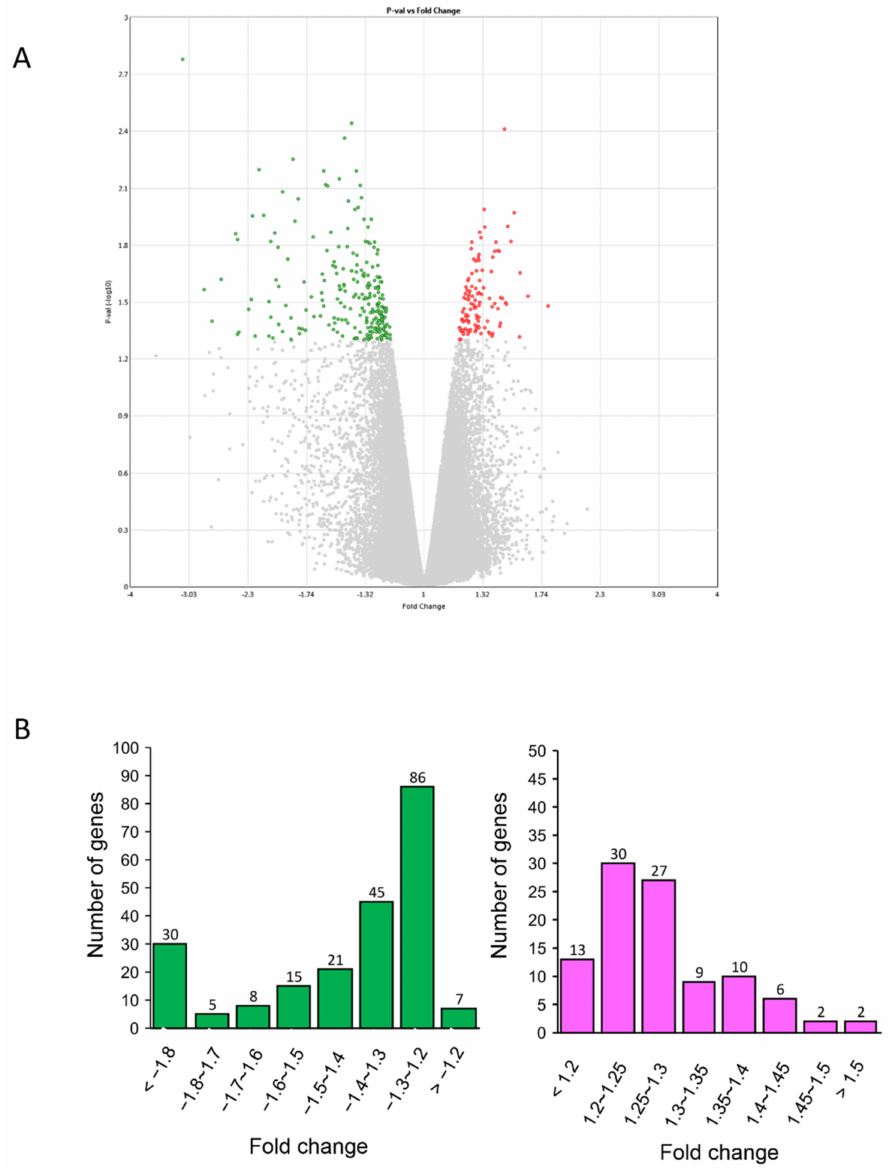
Figure 1. Characterization of gene expression profiles in human amniotic epithelial cells (hAECs) with or without cyanidin-3- O -glucoside (Cy3G) ( A ) Volcano plot displaying differentially expressed genes (DEGs) between Cy3G-treated and untreated hAECs on day 7. The vertical axis corresponds to − log10 p -value of the ANOVA p -values, and the horizontal axis displays linear fold change. The red dots represent the upregulated genes, and the green dots represent the downregulated genes. ( B ) distribution of fold changes of downregulated genes (left) and upregulated genes (right) in Cy3G-treated